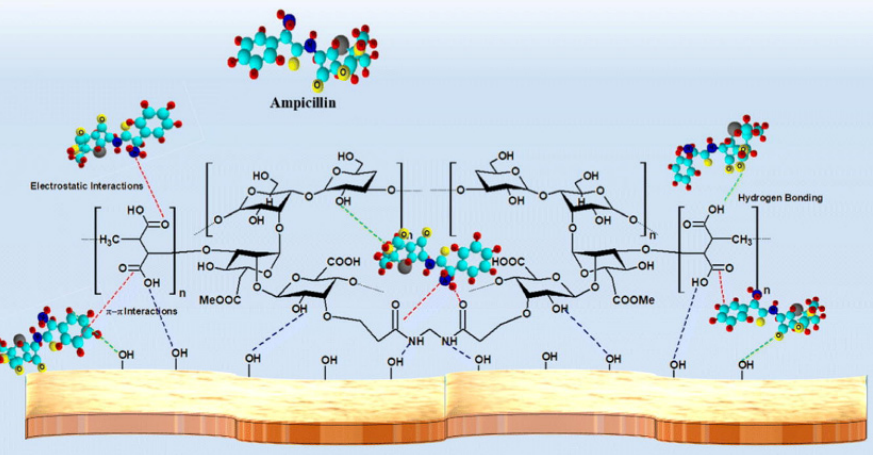
Figure 6. Adsorption of ampicillin onto the xanthan-based composite adsorbent